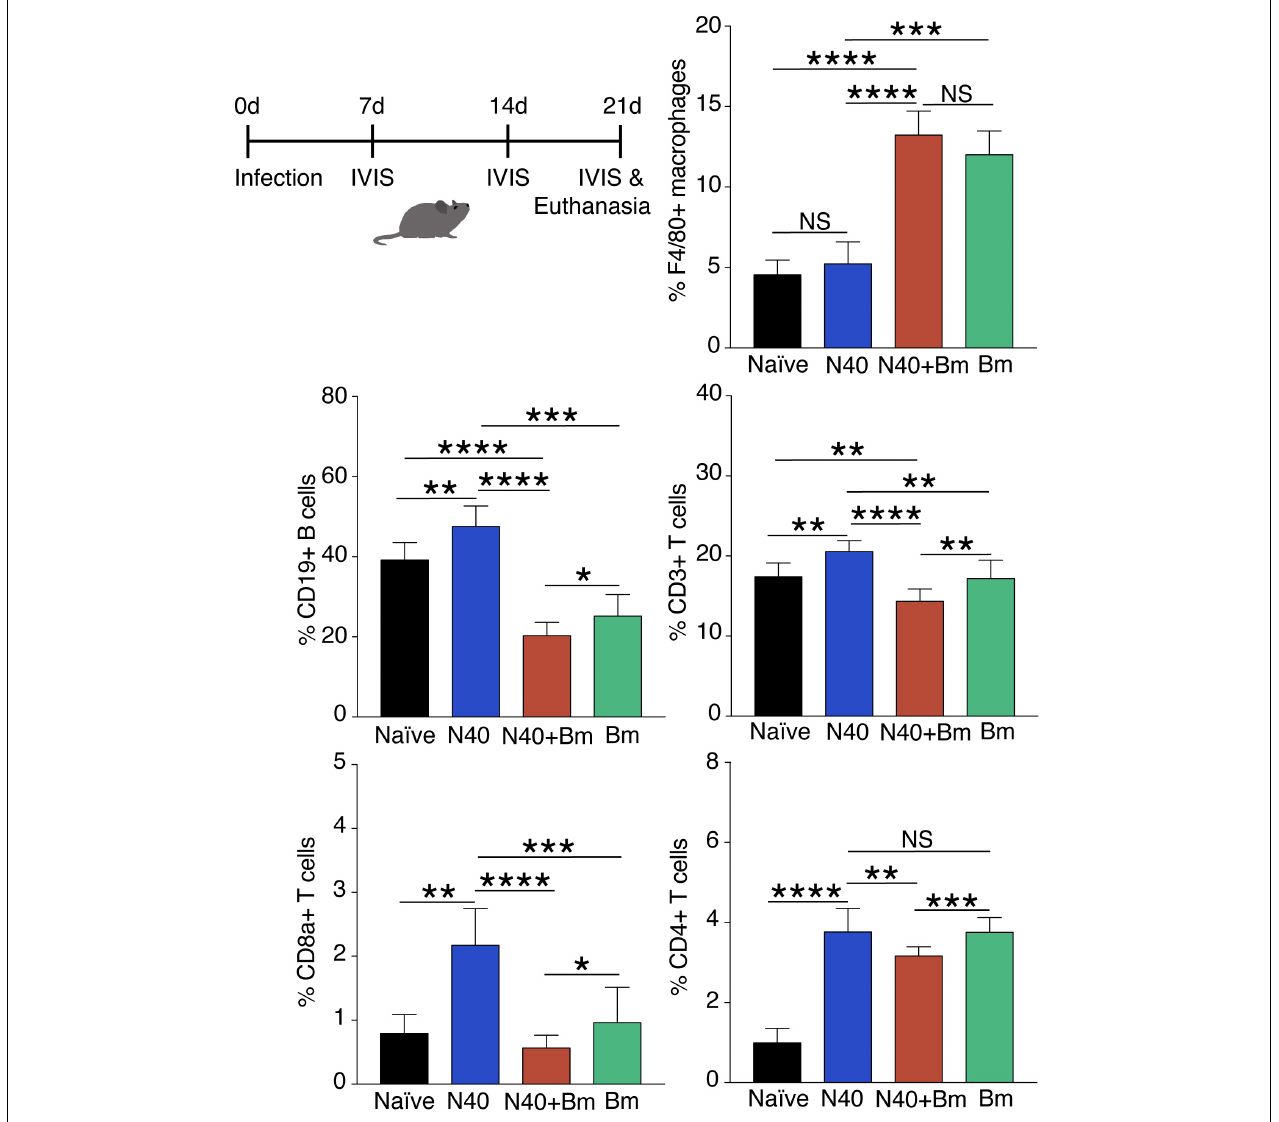
FIGURE 6 | Flow cytometry analysis of splenic leukocytes from infected mice at day 21 p.i. Percentage of each cell type in each mouse is calculated using total CD45+ cells and data presented as mean ± s.d. Increase in F4/80+ macrophage percentage remained significantly higher only in co-infected mice ( n = 10) compared to the naïve, uninfected mice ( n = 5). Significant but only moderate increase in T and B cells was observed in Bm infected mice ( n = 10). Increase in CD19+B cells, total CD3+ T cells, and CD8a+ cells in N40 infected ( n = 9) and Bm infected mice was observed at this stage while significant reduction in co-infected mice occurred compared to respective cells in mice infected with each pathogen individually. Increases in CD4+ T cells relative to naïve mice in Bm -infected and N40 infected mice were higher than in co-infected mice. Each bar represents the mean ± s.d. (NS, not significant, ∗ p < 0.05, ∗∗ p < 0.01, ∗∗∗ p < 0.001, ∗∗∗∗ p <